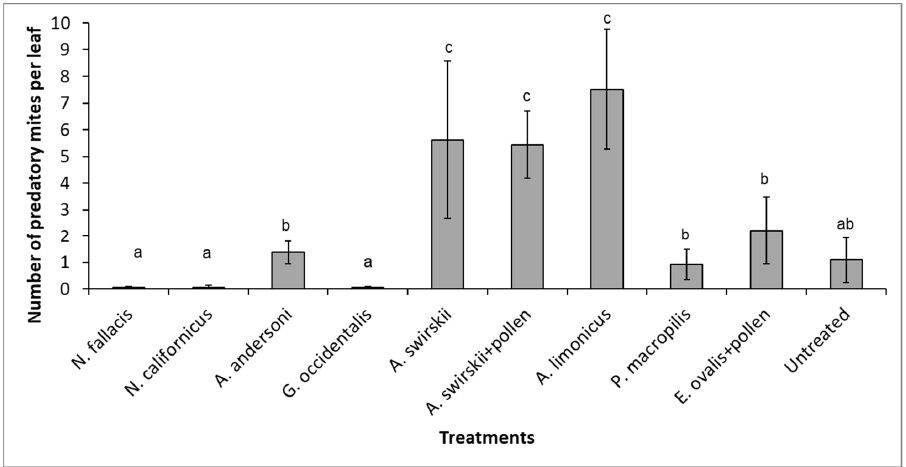
Figure 2. Number of established predatory mites (mean ± SE) on tomato plants infested with TRM six weeks after TRM inoculation and following four weekly curative releases of 500 predators per plant ( A. limonicus and A. swirskii found on untreated plants). Different letters above the data points denote significant differences among treatments after the generalized linear model ( p < 0.05).